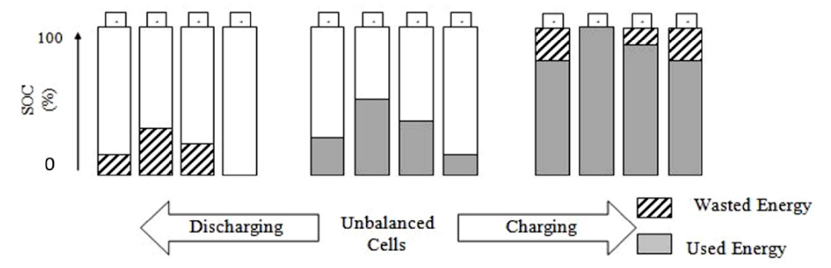
Figure 4. Effect of SOC imbalance on a battery pack (4-cell)